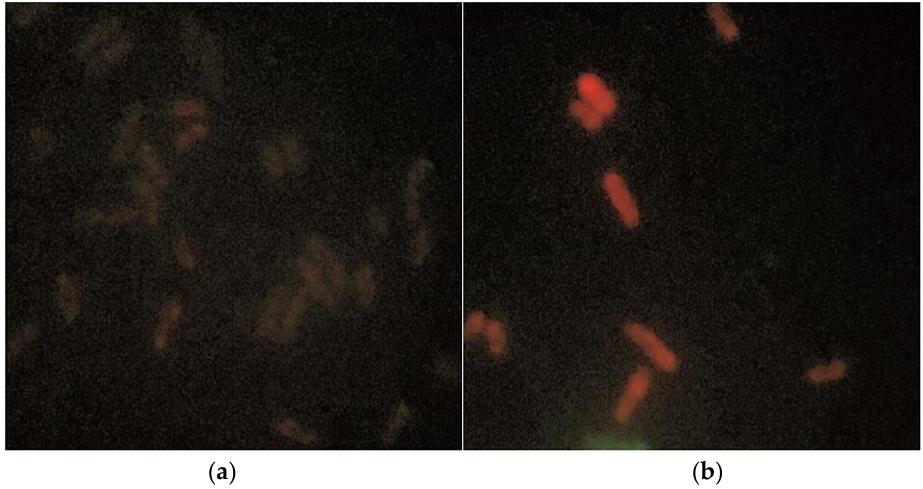
Figure 4. MitoTracker Red staining showed significant differences in the S. pombe MnSOD deleted eukaryotic model after mitocurcumin treatment. Both images use MitoTracker™ Red CM-H2Xros as ROS-sensitive mitochondria staining: ( a ) without any treatment and ( b ) after treatment with mitocurcumin 6 µM, 24 h.